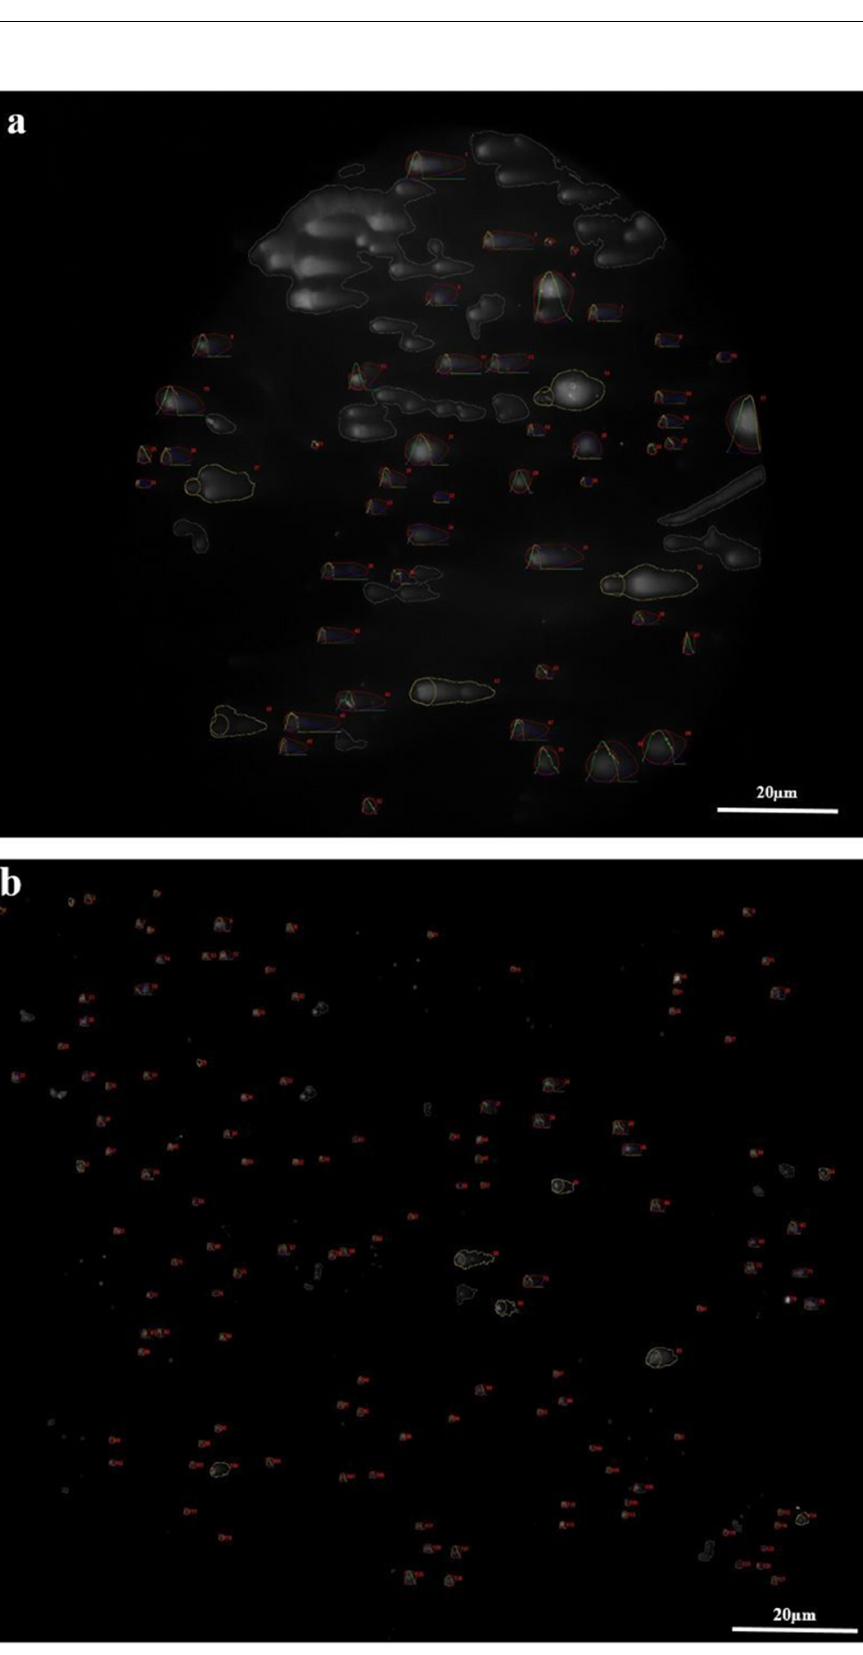
Figure 2. Olive moment ranges and mean differences between the study and control groups.